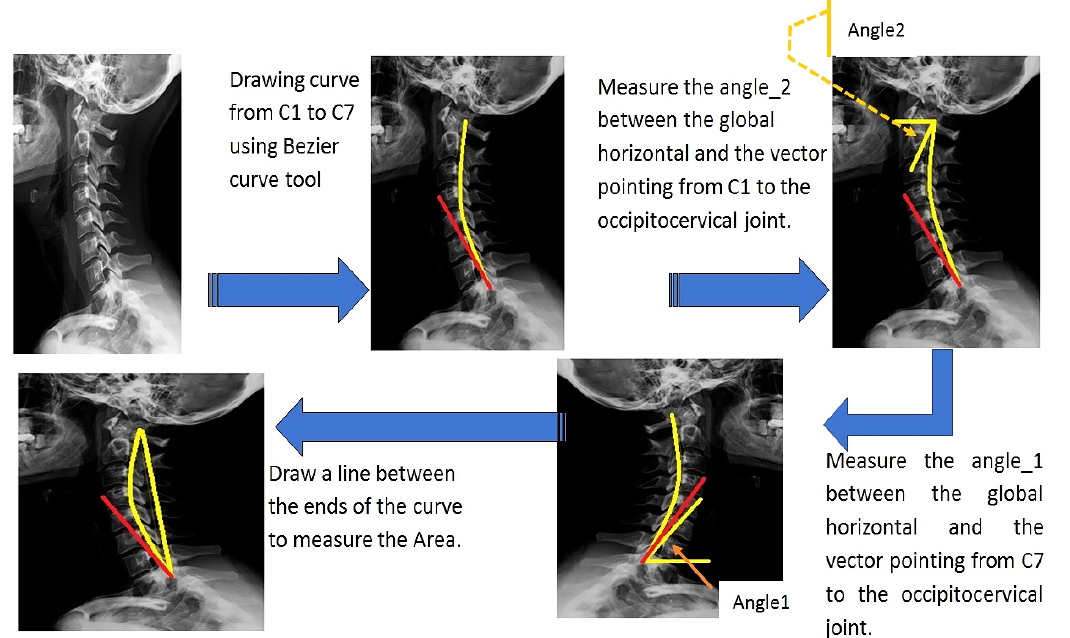
Figure 2. Angles and area measurements used as input of the decision tree (DT) to predict neck pain.